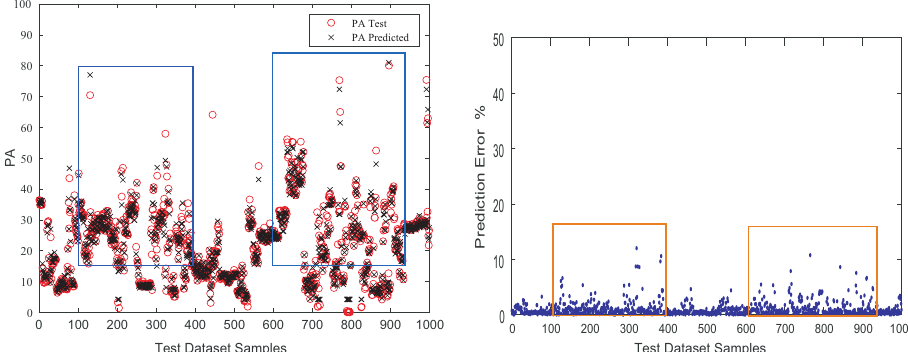
Figure 3. PA calculated vs. CNN prediction ( left ), CNN prediction error ( right ) using test dataset. Areas marked with high PA values where the highest prediction errors are